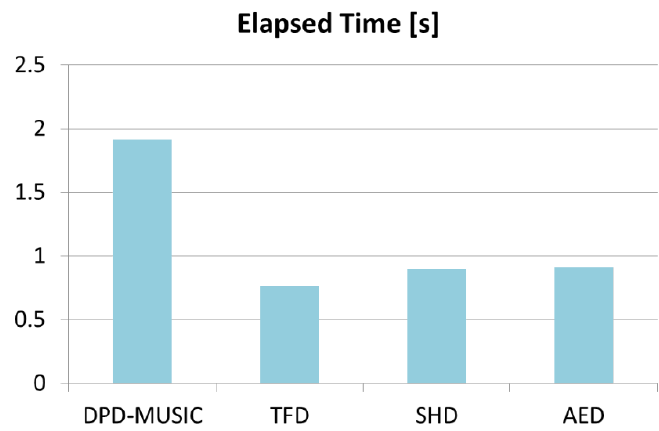
Figure 10. Elapsed time for different